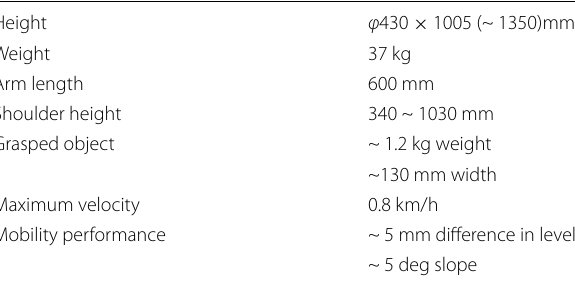
Table 1 HSR basic specifications